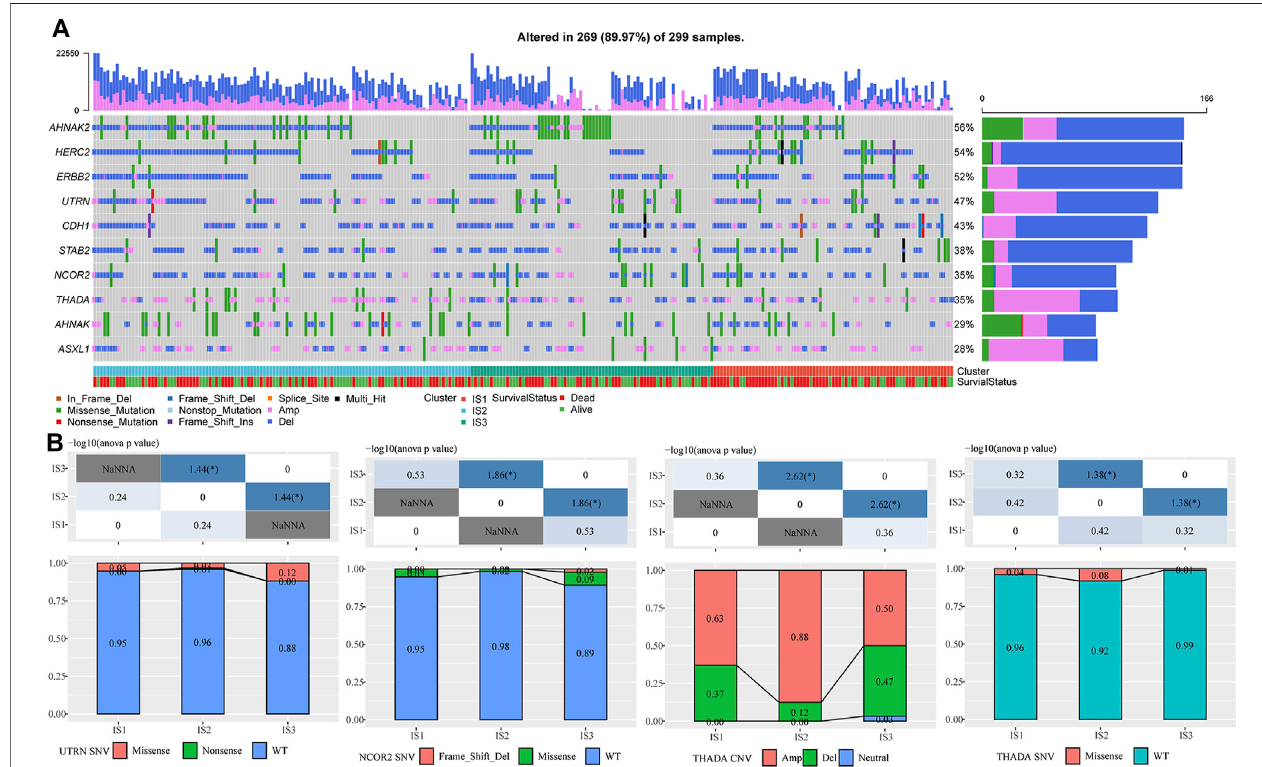
FIGURE2|(A) Mutationcharacteristicsofsigni fi cantlymutatedgenesineachIS. (B) DifferenceanalysisofUTRN,NCOR2,andThADAgenesinimmunesubtypes. The chi-square test determined the p -value. p < 0.05 is represented by *, while p < 0.01 is represented by **.